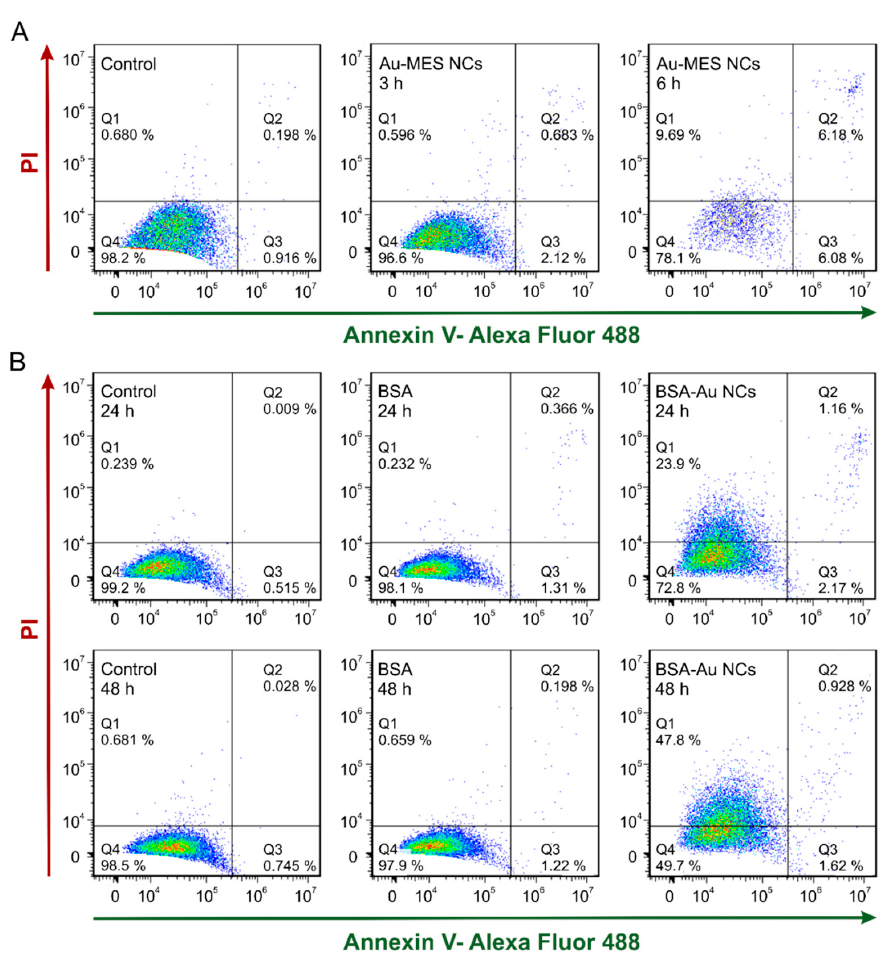
Figure 8. Apoptosis analysis of MDA-MB-231 cells after incubation with Au-MES NCs for 3 and 6 h ( A ); and BSA and BSA-Au NCs for 24 and 48 h ( B ) by flow cytometry, using Annexin V/ PI apoptosis assay. Only PI positive population (Q1) represents necrotic cells whereas only Annexin V positive population (Q3) are early apoptotic cells. Cells in late apoptosis take up both dyes (Q2). Q4 represent live cells. In the case of cells treated with BSA-Au NCs, population Q1 displays BSA-Au NCs positive cells.2.4. ROS Generation of Au NCs in Cancer Cells